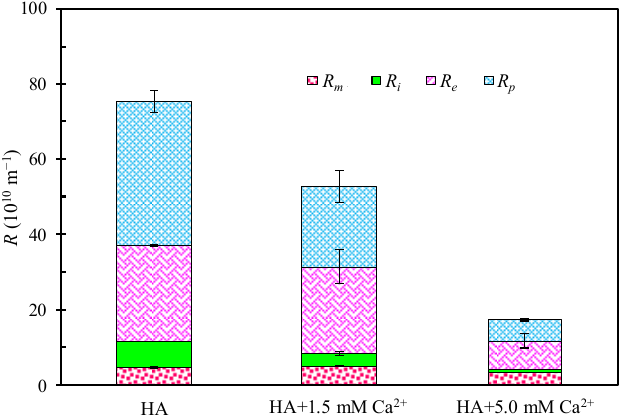
Figure 2. Influence of Ca 2+ concentration on experimental hydraulic resistances ( R p , R e , R i , R m ) of HA ( ∆ P = 2 bar).